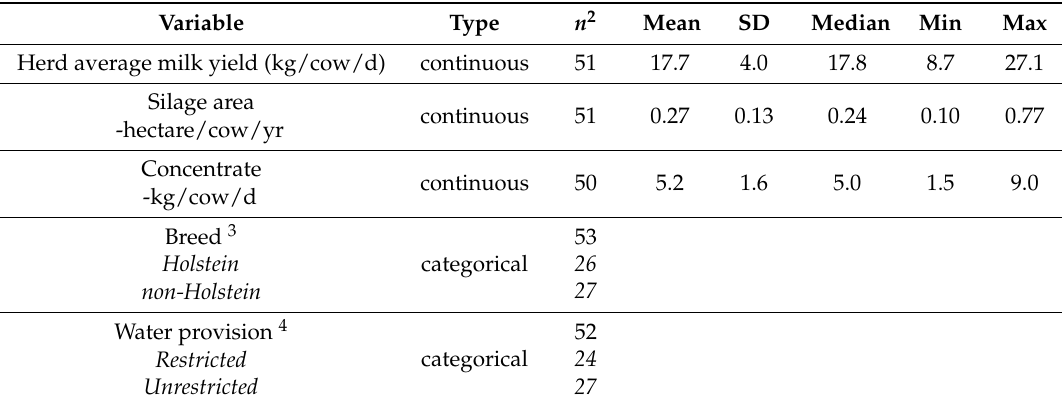
Table 2. Description of variables included in the final model 1 .